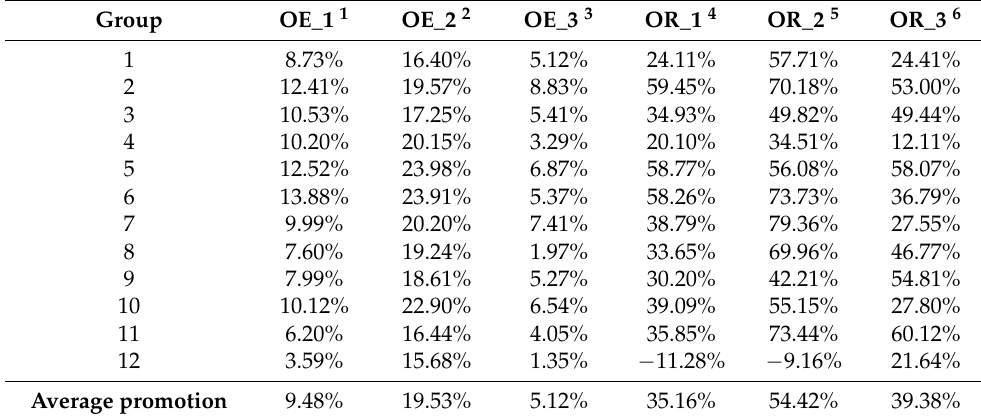
Table 7. The optimization efficiency and robustness of algorithms.